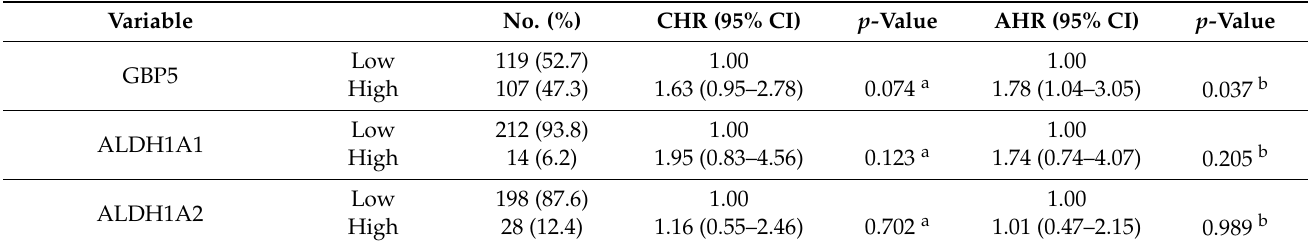
Table 5. The co-expression of GBP5 and cancer stemness markers in disease-free survival of oral cancer patients from TCGA